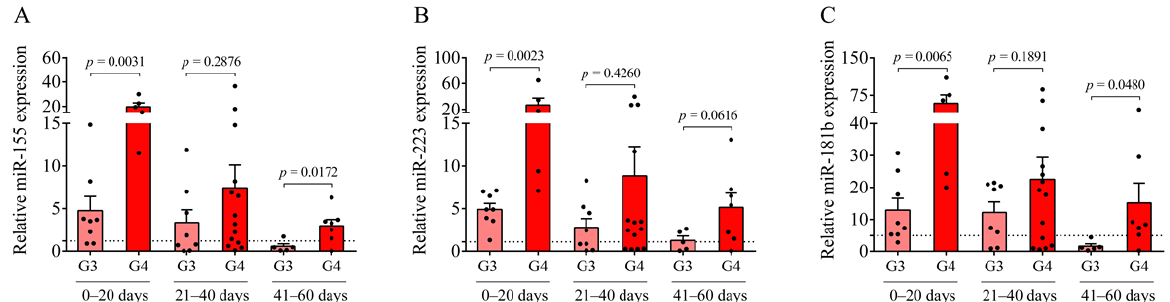
Figure 4. The expression of cell-free miRNAs between Grade-III (G3, light red) and Grade-IV (G4, red) preterm IVH groups. In CSF samples collected between 0 and 20, and 41 and 60 days after the onset of IVH, miR-155 ( A ), miR-223 ( B ), and miR-181b ( C ) were elevated in the grade-IV IVH group compared to the IVH-III group. Dots represent single expression values. Mean ± SEM are depicted. Dotted lines depict the mean value of the particular extracellular miRNA analyzed in preterm non-IVH control samples [23]. To compare the data of two groups, the Mann–Whitney U test or unpaired t -test was applied. Abbreviations: CSF, cerebrospinal fluid; G3, Grade-III IVH; G4, Grade-IV IVH; IVH, intraventricular hemorrhage; and miRNA,